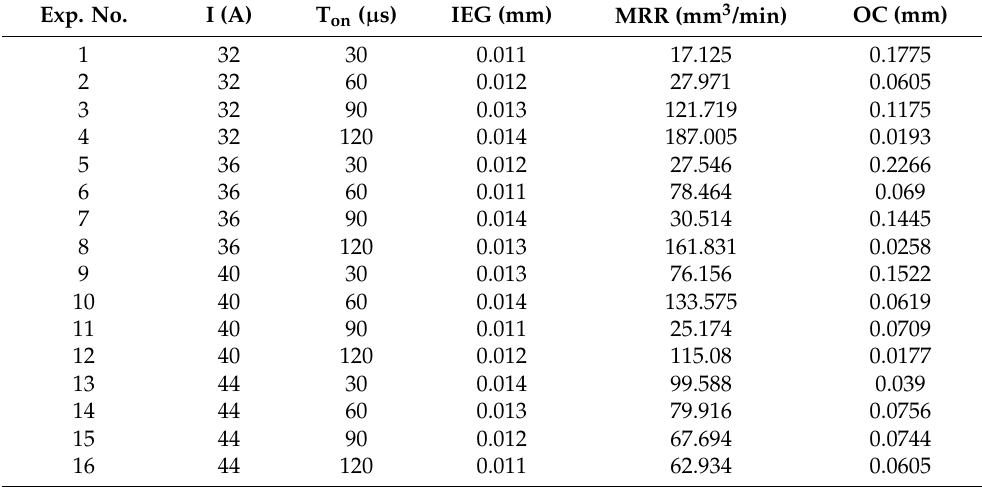
Table 5. Experimental details. Peak current (I). Pulse-on time (T on ). Inter-electrode gap (IEG). Material removal rate (MRR). Overcut